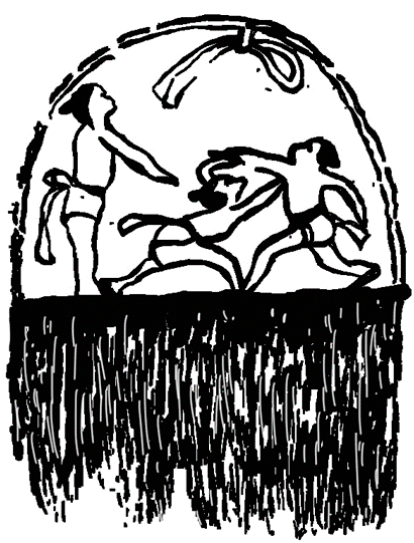
Figure 22. A wooden comb discovered in Jiangling 江陵 , Hubei 湖北 , decorated with the depiction of